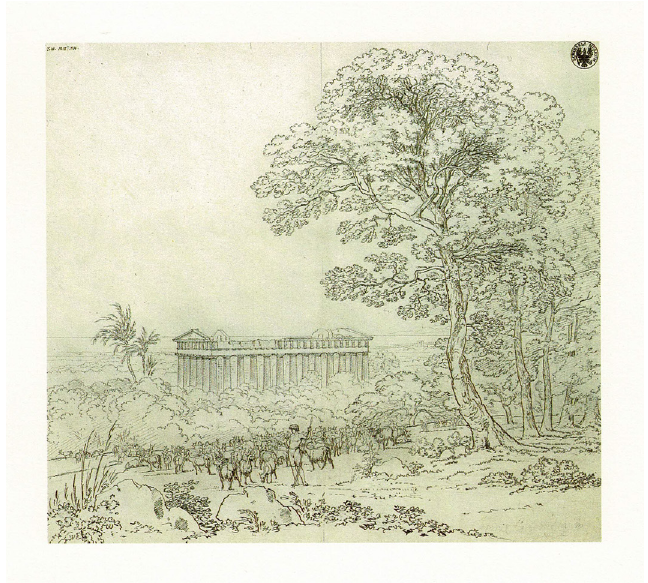
Fig. 1 K. F. Schinkel, The temple